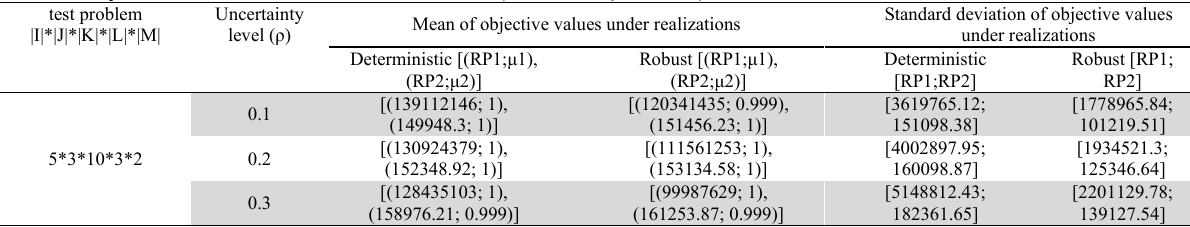
Summary of test results under realizations ( (cid:2016) (cid:3404) 0.5 , (cid:2011) (cid:3404) 0.9 )